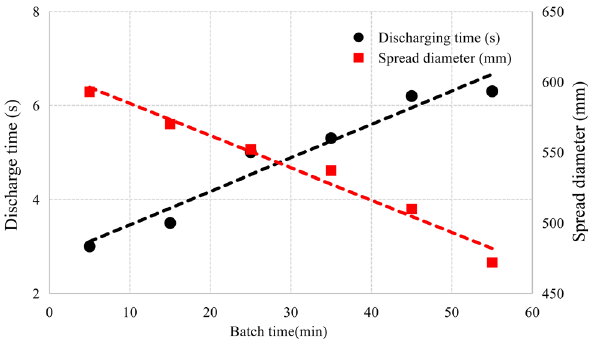
Figure 6: Discharge time and spread diameter with di ff erent batch time through V - funnel experiment for